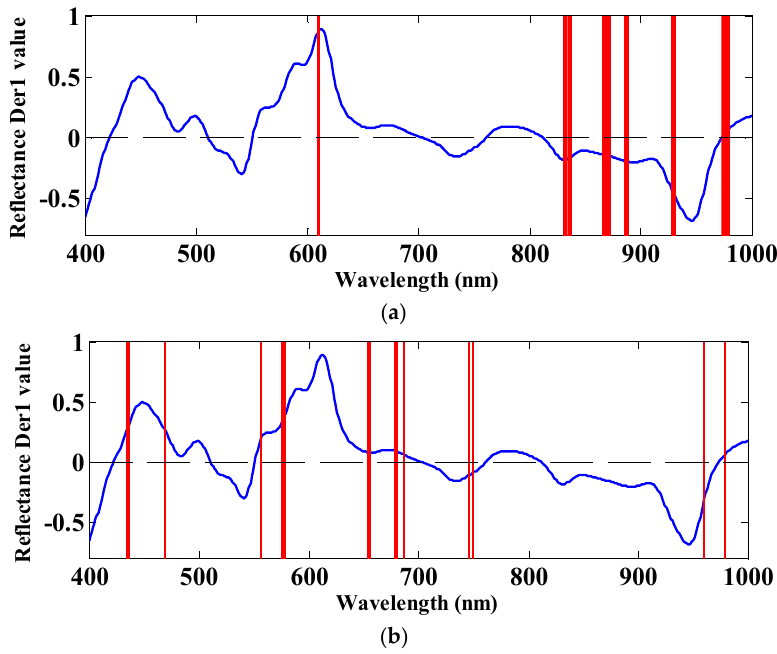
Figure 6. The indication of selected wavelengths by ( a ) CARS and ( b ) UVE. Blue lines: original Der1 spectral curve; Red lines: selected wavelengths. Table 3. Performance comparison of full-wavelength and simplified PLS-DA models based on selected wavelengths by competitive adaptive reweighted sampling (CARS) and uninformative variable elimination (UVE).